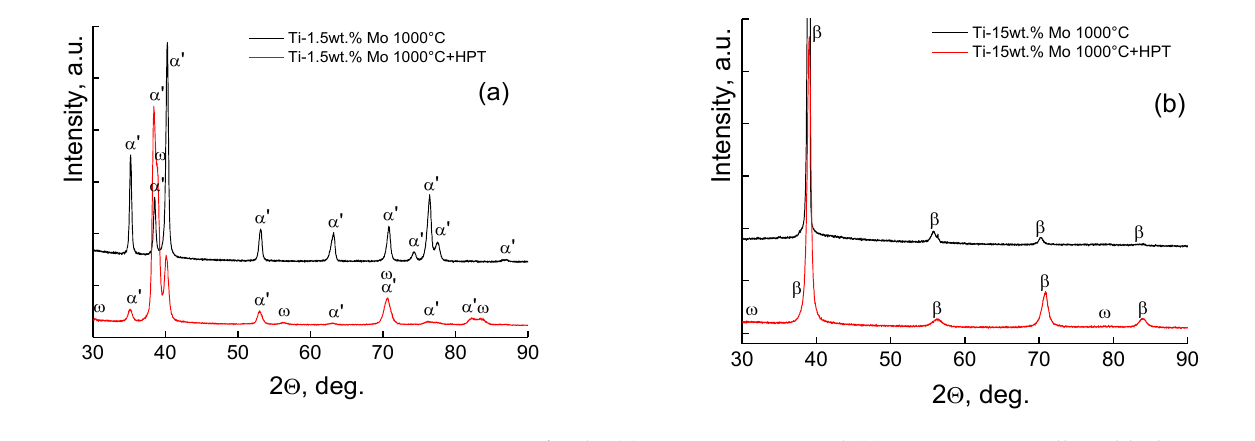
Figure 3. SEM micrographs of Ti – 15 wt.% Mo alloy annealed at 1000 °C for 24 h and after HPT: ( a ) R 0 is the center, ( b ) R 1/2 is the middle of the radius, ( c ) R 1 is the edge of the sample. Figure 4 shows the XRD patterns of samples before and after the HPT: the black curves correspond to the states after annealing, and the red curves to those after HPT. HPT leads to a broadening of peaks and to the decrease in their intensity. In addition, HPT leads to the α′ → ω phase transition in the Ti– 1.5 wt.% Mo alloy and to the β → ω trans- formation in the Ti – 15 wt.% Mo alloy. Table 2 presents data on the volume fraction of phases, lattice parameters, and the average grain size of the phases after HPT. Note that the volume fraction of the ω phase in the Ti– 15 wt.% Mo alloy is small; therefore, the peak intensities of this phase are small too.